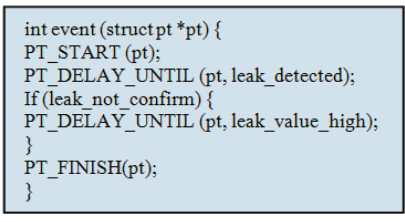
Figure 8. Event driven code design abstraction for data sensing model.